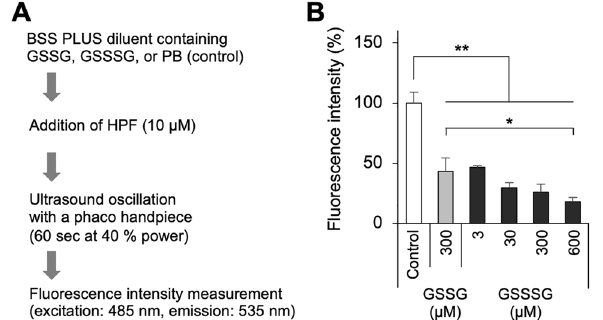
Figure 3. Effect of GSSSG on ultrasonication-induced ROS. ( A ) Experimental procedure for measurement of ultrasonication-induced ROS in glutathione-containing solutions treated with a phaco handpiece. ( B ) Effects of GSSSG and GSSG on ultrasonication-induced ROS. Fluorescence intensity is shown as a relative value to that of PB-containing control solution. Error bars indicate standard error of the mean. *P < 0.05 and **P < 0.01 (Dunnett’s test, Tukey–Kramer test; n =